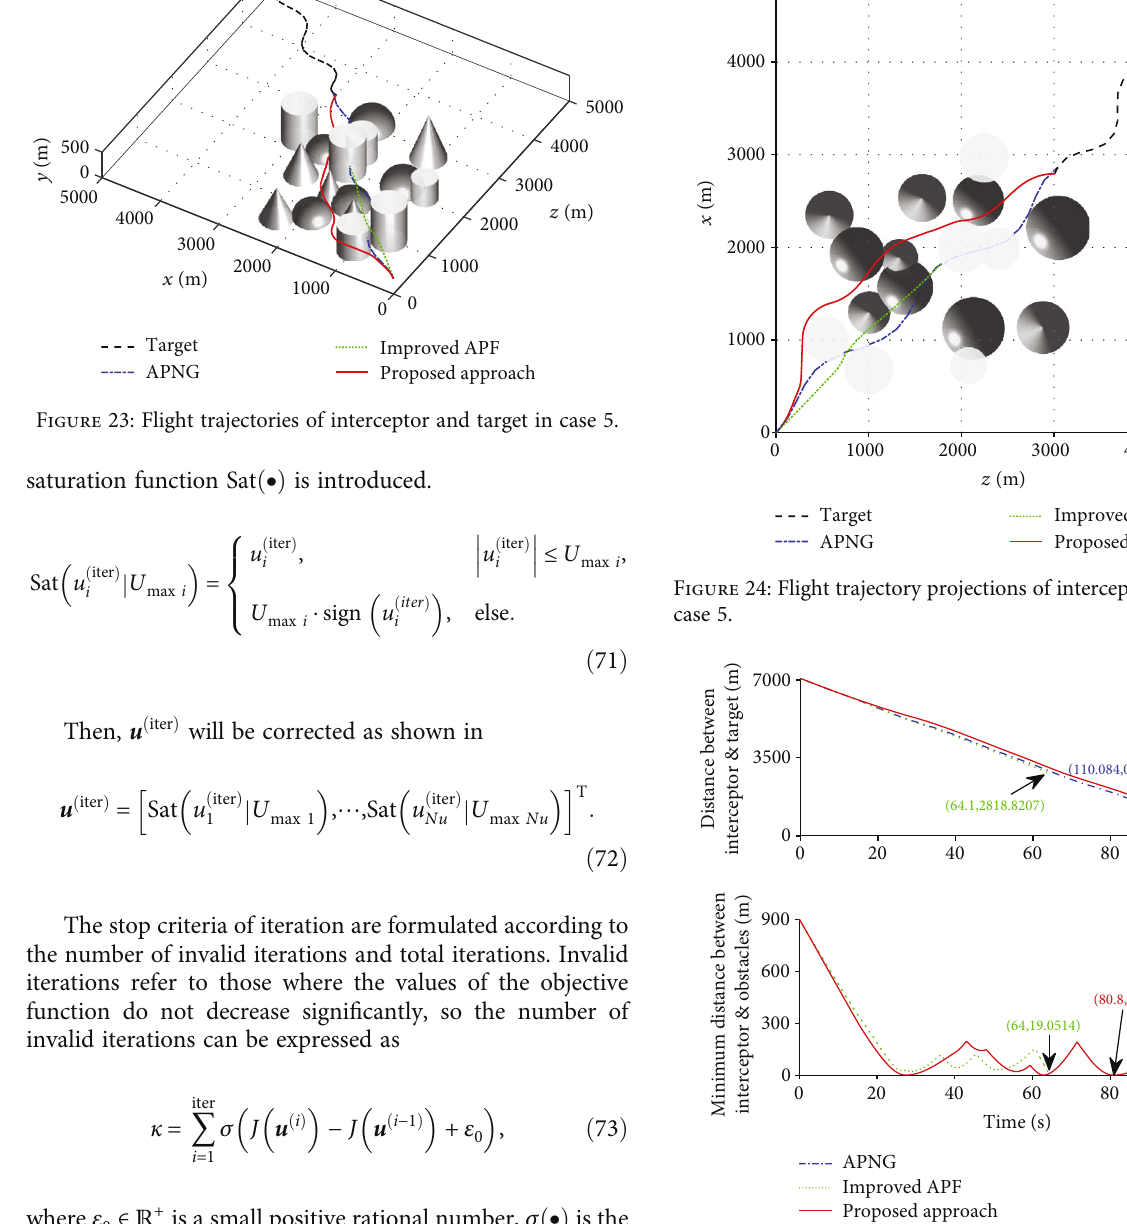
Figure 25: Changes of two distances in case 5.